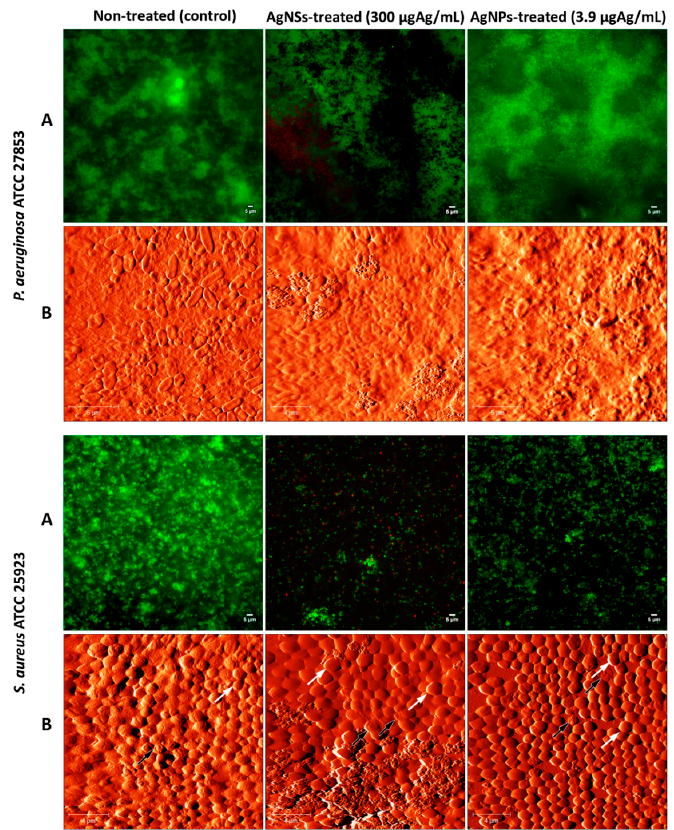
Figure 1. Qualitative evaluation of biofilms treated with AgNSs and AgNPs. Live/Dead images ( A ) and AFM images ( B ) of 24-h biofilms of P. aeruginosa ATCC 27853 and S. aureus ATCC 25923 non treated (controls), and treated with AgNSs (300 µ g Ag / mL) or AgNPs (3.9 µ g Ag / mL) for further 24 h. Some damaged S. aureus cells are highlighted by black arrows, and healthy cells by white arrows.